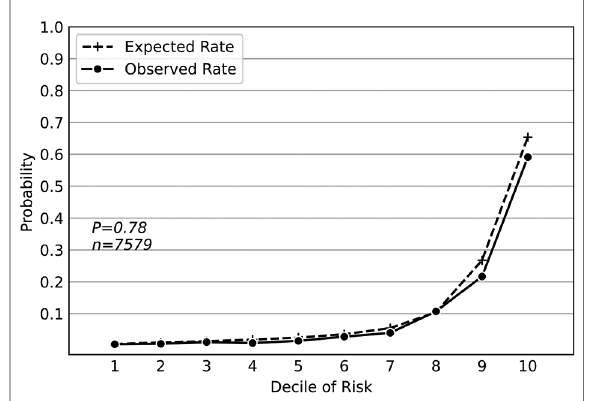
FIGURE 2 Hosmer-Lemeshow calibration plot of the deep neural network model based on the external dataset. Values on the x-axis are deciles of predicted risk of postoperative pulmonary complications and values on the y-axis are rates of postoperative pulmonary complications for each decile. The result of Hosmer – Lemeshow test ( P =0.78) showed good agreement between the deep neural network model-based prediction and observed outcome.